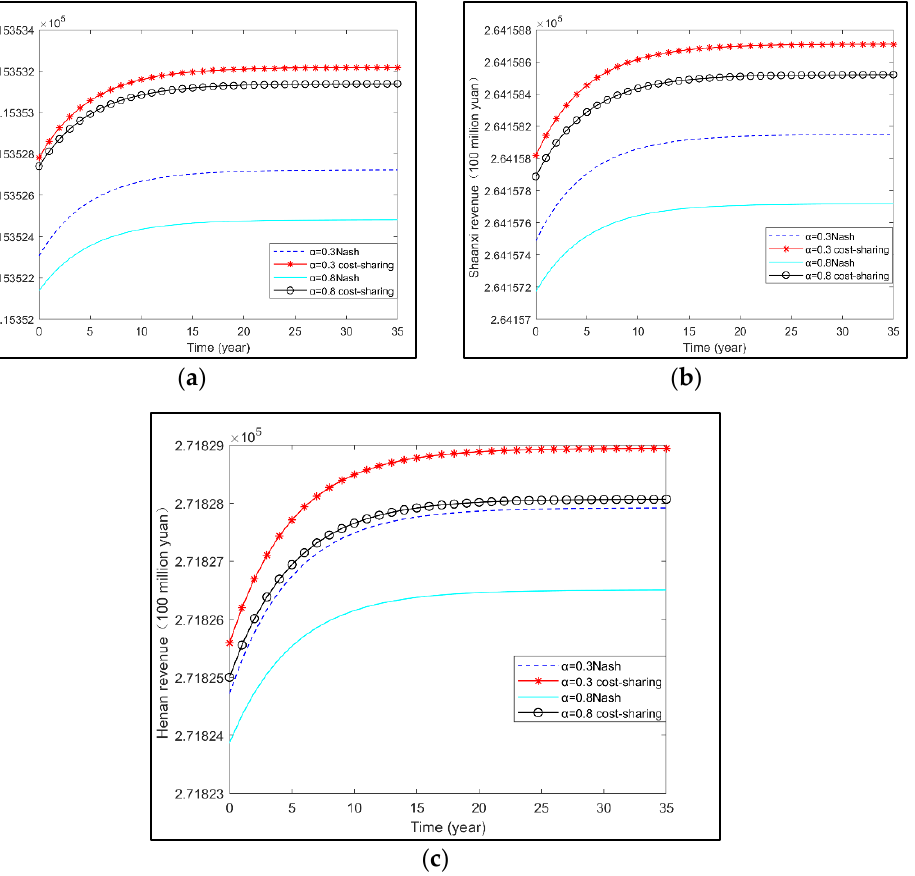
Figure 6. The effects of competition coefficient α on the three governments’ revenues: ( a ) the Shanxi province government’s revenues, ( b ) the Shaanxi province government’s revenues, and ( c ) the Henan province government’s revenues.